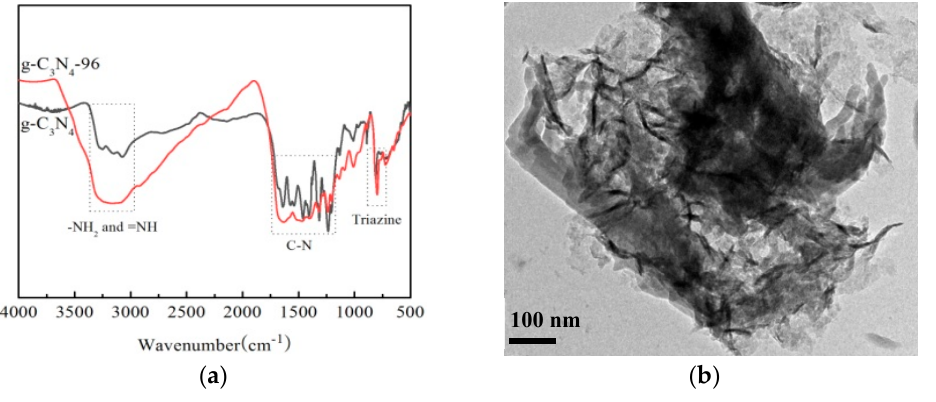
Figure 2. FTIR spectra ( a ) and TEM images ( b ) of g-C 3 N 4 -96.